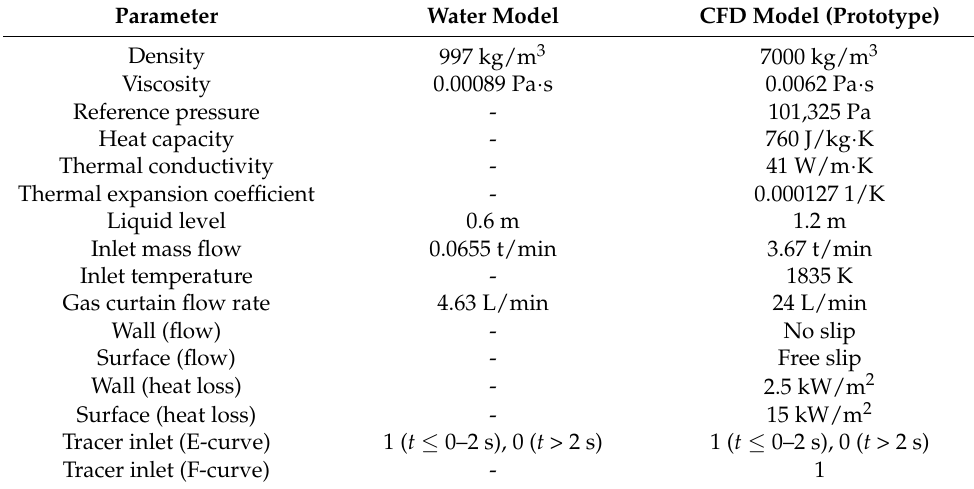
Table 2. Input parameters and boundary conditions used for water model and CFD